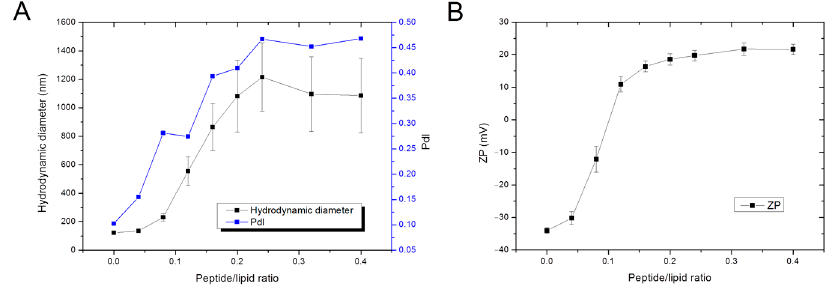
Figure 7. Effect of NAPHT ‐ BP100 over LUV’s hydrodynamic diameter (Dh) and Zeta potential (ZP). ( A ) Dh and polydis ‐ persity (PdI), and ( B ) ZP of POPC:POPG (50:50) LUV, as a function of peptide/lipid ratio. Lipid concentration was 50 μ M in 10 mM Tris ‐ HF buffer, pH 7.4. Temperature was 25 °C.